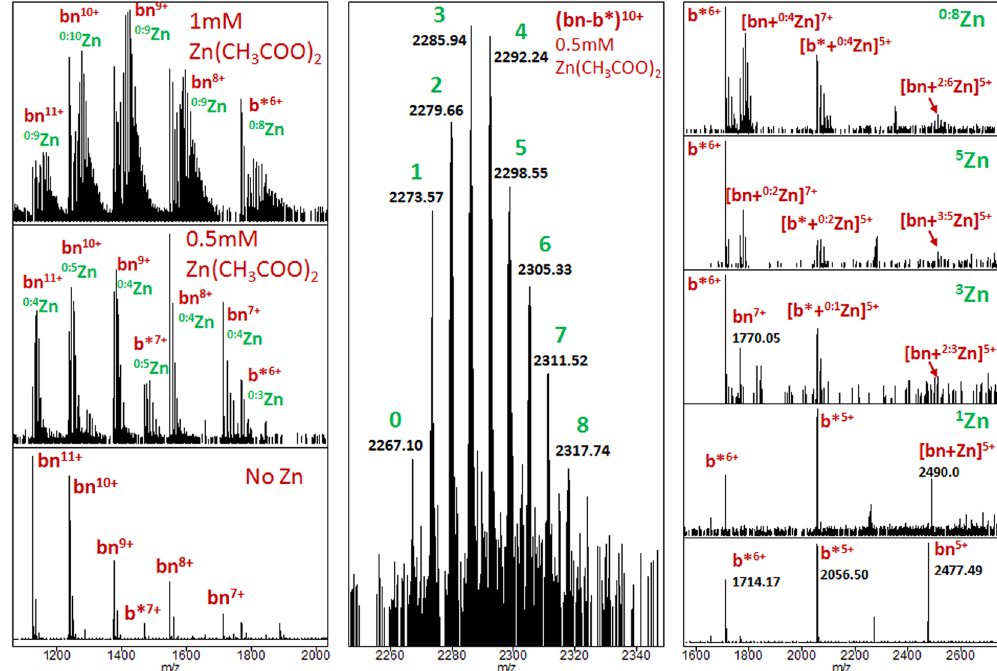
Figure 4. The supermetallization experiment. Temperature 450 °C. Left – the broad band mass spectrum under supermetallization conditions for different concentrations of Zn(CH 3 COO) 2 . Center – zoomed on the supermetallized [bn-b * ] 10 + . This spectrum was obtained by isolating ions in the ion trap using an isolation window of 100 Da around the m/z = 2300. Right – isolation and fragmentation of the ions of [bn-b * ] 10 + carrying different numbers of Zn atoms. Green labels indicate the number of Zn atoms in the complex ion. x:y Zn means that ions are carrying from x to y atoms of